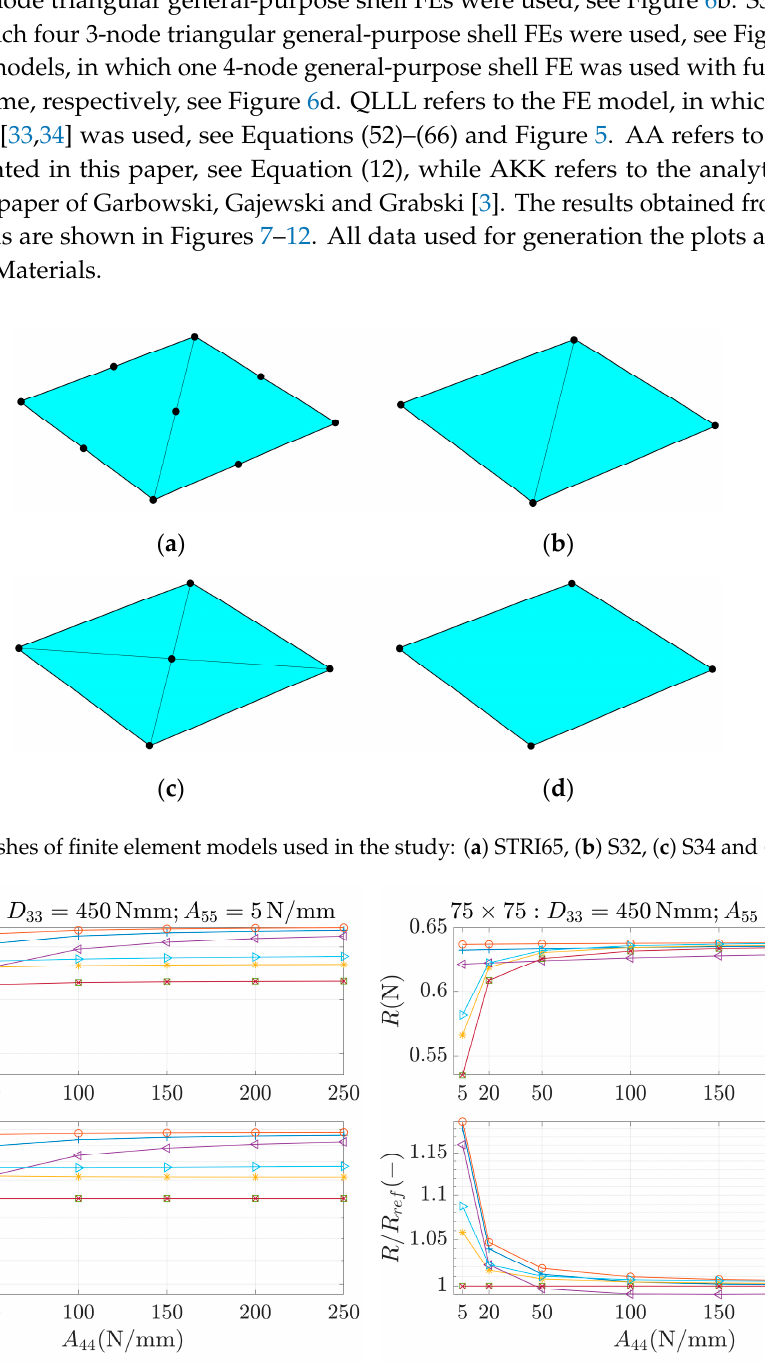
( b ) Figure 8. Reactions (first row) and reactions to the reference (analytical) solution (second row) for 75 × 75 sample, 𝐷 (cid:2871)(cid:2871) = 900 Nmm and different values of 𝐴 (cid:2872)(cid:2872) . ( a ) 𝐴 (cid:2873)(cid:2873) = 5 N/mm and ( b ) 𝐴 (cid:2873)(cid:2873) = 250 N/mm.